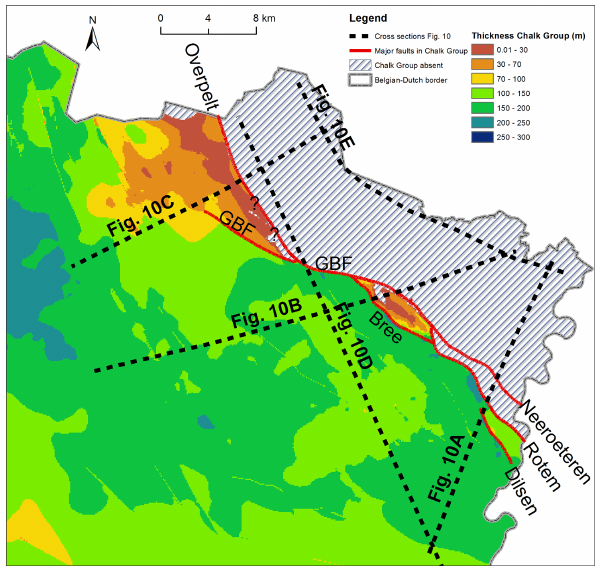
Figure 9. Map showing the thickness of the Chalk Group and major reverse or thrust faults that influenced it in the study area from the G3Dv3 model. The locations of the cross sections in Fig. 10 are indicated. Note that our informal definition of the Chalk Group only contains those parts of the formal Chalk Group that were deposited during inversion of the RVG and are therefore missing in the latter. Younger formations of the formal Chalk Group are grouped in the pre-rift strata for the purpose of this study. Question marks indicate uncertainties in the fault